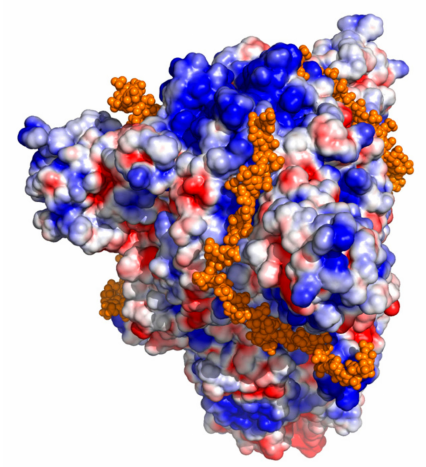
Figure 1. Model SARS-CoV-2 omicron variant spike protein—heparin complex. The solvent-accessible surface of the protein shown is colored by electrostatic charge, with negative regions blue and positive regions red. The modeled heparin is shown as orange spheres, with one strand of heparin bound to a groove in each of the trimeric spike protein